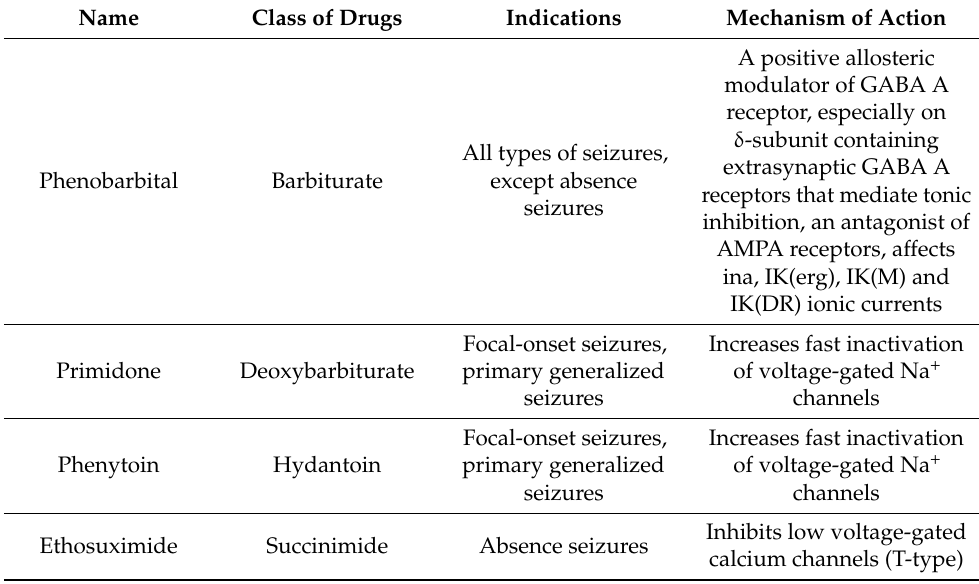
Table 1. Currently available antiseizure medications and their mechanisms of